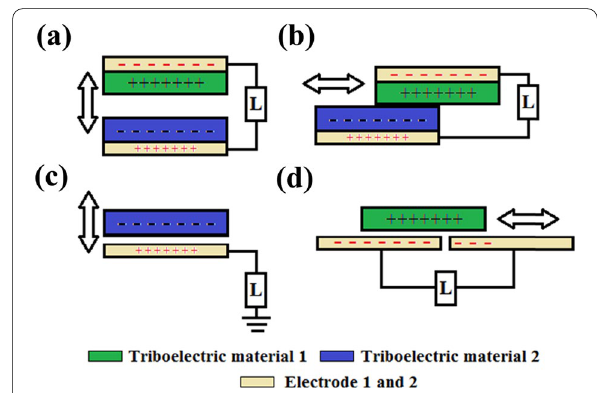
Fig. 2 The four fundamental operation modes of TENG: a Vertical contact-separation mode (VCSTENG), b lateral sliding mode (LSTENG), c single-electrode mode (SETENG) and d freestanding triboelectric-layer mode